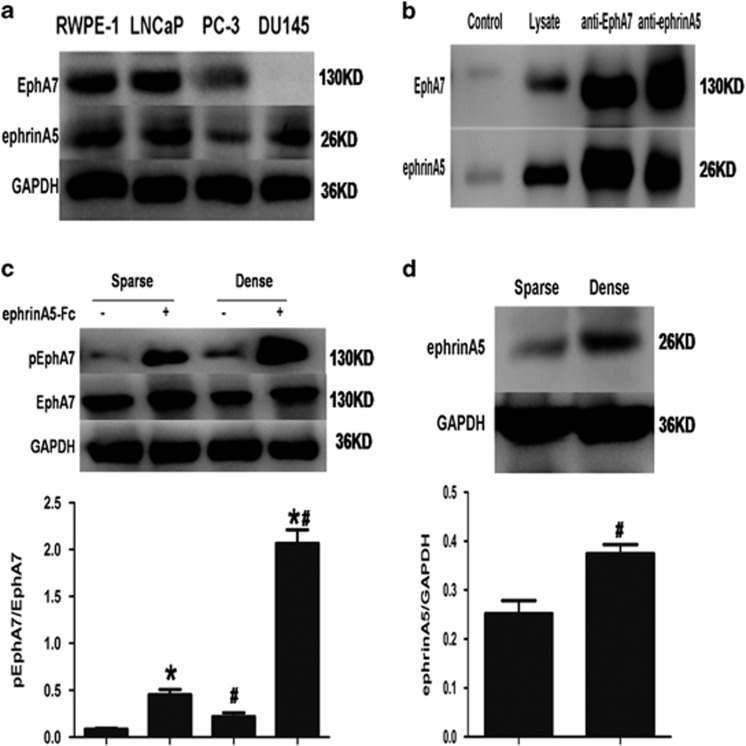
The phosphorylation of EphA7 receptor was regulated by cell density. (a) The protein expression of EphA7 and ephrinA5 was analyzed by western blotting in four prostate cell lines. (b) The interaction between EphA7 and ephrinA5 in LNCaP cells by co-immunoprecipitation and western blot analysis. (c) The phosphorylation analysis of EphA7 receptors by immunoprecipitation. Dense (approximately 100% confluence) and sparse (approximately 30% confluence) LNCaP cells were serum-deprived for 24 h and then stimulated with 1.0 μg/ml ephrinA5-Fc or Fc for 15 min. The EphA7 protein was enriched using immunoprecipitationwith anti-EphA7 antibody and then divided in two aliquots for immunoblotting with anti-EphA7 antibody and anti-phosphotyrosine (4G10) antibody. (d) Western blot analysis of expression of the ephrinA5 ligand. Data are shown as the mean±S.D. *P<0.05, versus the corresponding LNCaP cells without the stimulation of ephrinA5-Fc; #P< 0.05, versus the correspondingly sparse LNCaP cells